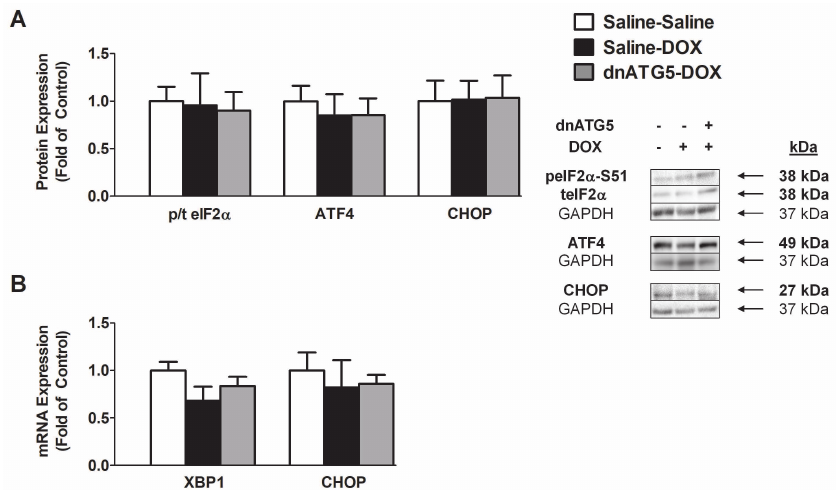
Figure 4. Markers of endoplasmic reticulum stress in the soleus muscle. ( A ) Ratio of phosphorylated to total eukaryotic translation initiation factor 2 subunit 1 (eIF2 α ) (p / t eIF2 α ), activating transcription factor 4 (ATF4) protein expression, and C / EBP homologous protein (CHOP) protein expression. ( B ) mRNA expression of x-box binding protein 1 (XBP1) and CHOP. Values are represented as means ± SEM. Representative Western blot images are shown to the right of the